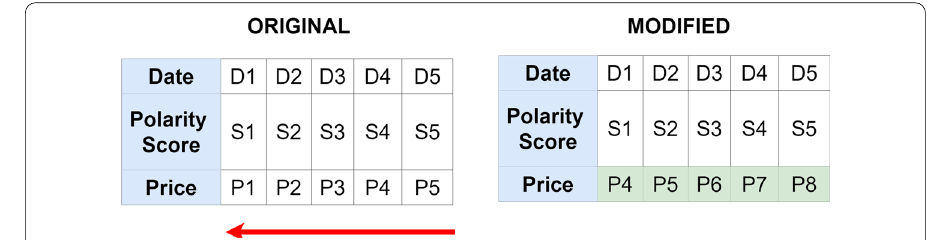
Fig. 3 Lagged dataset example with lag